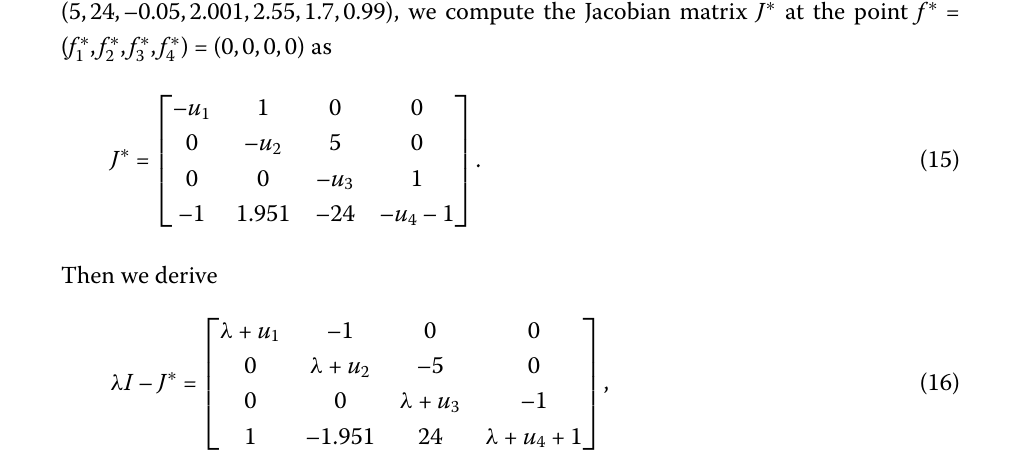
where u i ≥ 0 is the state-feedback control gain. The objective is to design u i in such a way that the state variables f 1 , f 2 , f 3 , f 4 of the controlled system (14) converge to the steady- state f ∗ = (0,0,0,0) asymptotically. Considering the system parameters ( α , β , γ , ε , η , κ , θ ) = (5,24,–0.05,2.001,2.55,1.7,0.99), we compute the Jacobian matrix J ∗ at the point f ∗